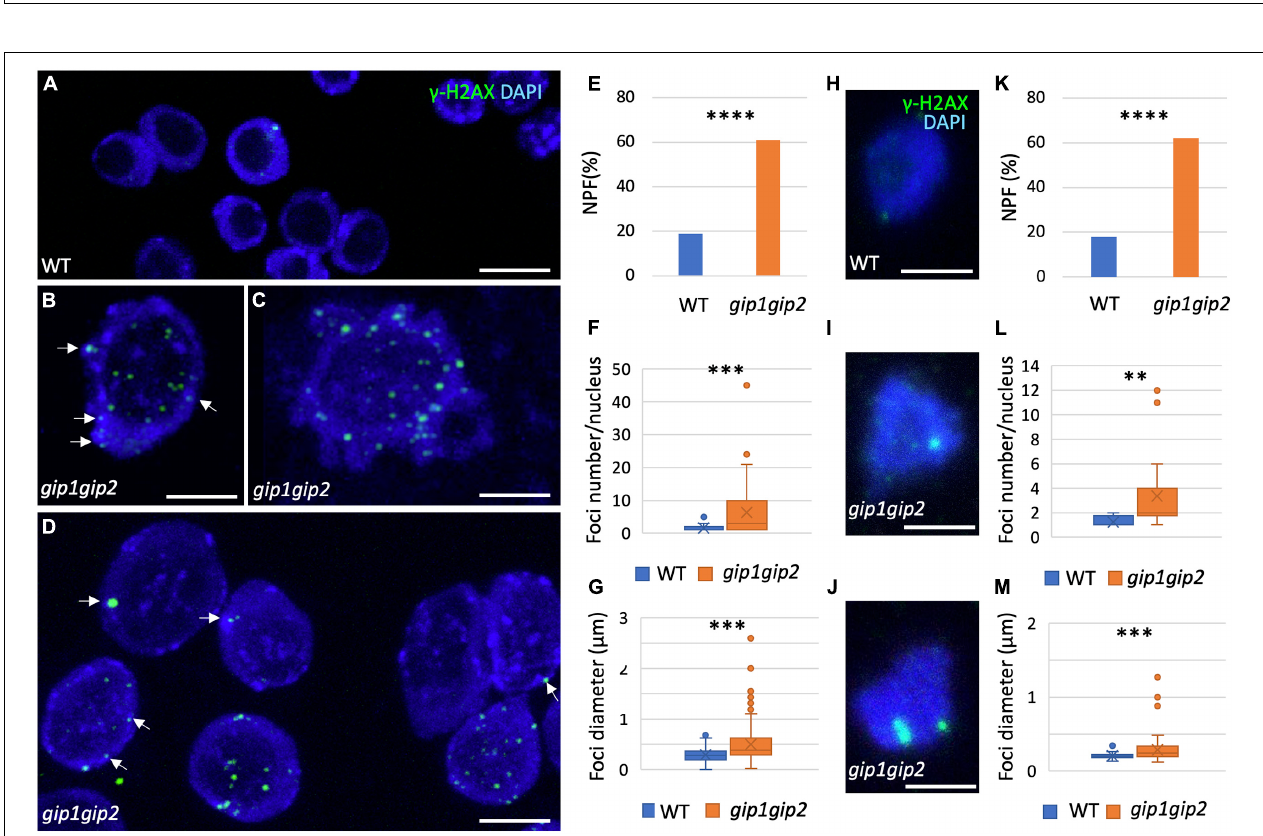
FIGURE 2 | Characterization of the γ -H2AX foci in root meristematic nuclei. (A–D,H–J) Immunolocalization was performed on nuclei from squashed root tips of 9-day-old seedlings using specific anti- γ -H2AX antibody and DAPI staining in WT (A) and gip1gip2 (B–D) as well as on 2C flow sorted nuclei from WT (H) and gip1gip2 (I,J) root seedlings. Representative images are presented. White arrows indicate foci close to the bright DAPI-stained chromocenters. (E–G,K–M) Different characteristics regarding the γ -H2AX foci were quantified in WT ( n = 249) and gip1gip2 ( n = 133) nuclei from root meristem nuclei and in 2C flow sorted nuclei from WT ( n = 54) and gip1gip2 ( n = 61), such as the percentage of Nuclei Presenting Foci (NPF; E,K ), the number of foci per nucleus (F,L) and the foci diameters (G,M) . Results were obtained from four independent roots. The Fisher’s exact test was used and the two-tailed-value is < 0.0001 ( ∗∗∗∗ ) in panels (E,K) . The Mann Whitney test was used in panel (F,G,L,M) where p- values are indicated as < 0.01 ( ∗∗ ) and < 0.001 ( ∗∗∗ ). Scale bar = 5 µ m.